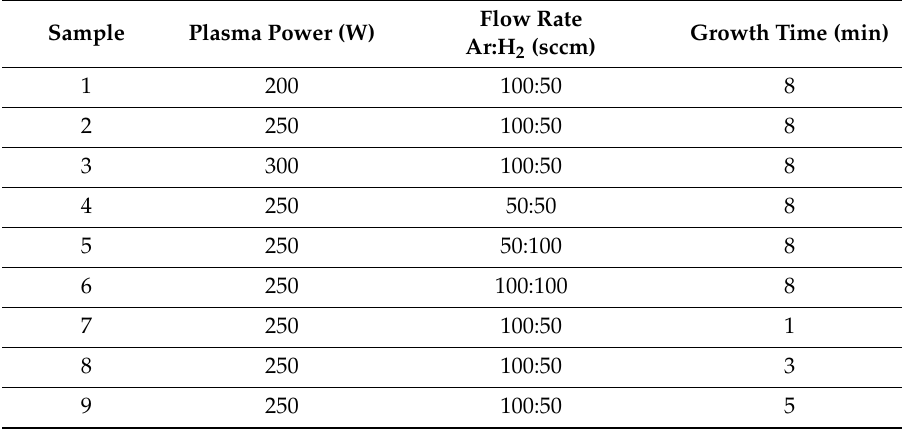
Table 1. Experimental conditions for plasma-assisted structure reformation of RF gel to